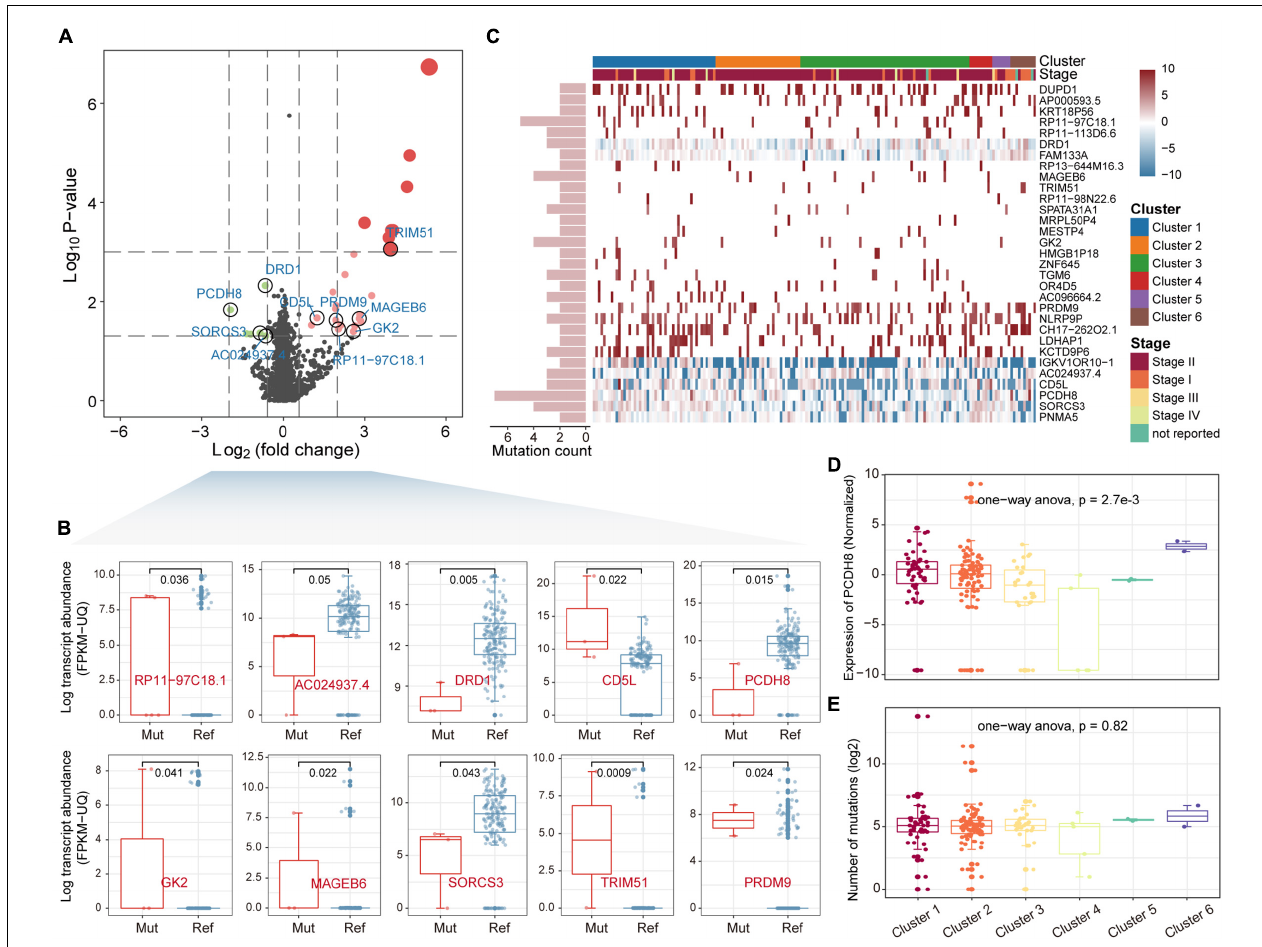
FIGURE 2 | Identification of driver genes. (A) The differential expression analysis comparing mutated and unmutated patients. Differentially expressed genes were shown as red or green dots. (B) Expression level of the top 10 driver genes between mutated and unmutated samples was shown by boxplot. The rank sum test was used to check the significance. (C) Distribution of driver gene expression in the samples. Column labels indicate the cluster and stage to which the sample belongs. Row labels indicate the number of mutations in each driver gene. (D,E) Expression and mutation levels of the driver gene PCDH8 between the 6 clusters of samples were shown by